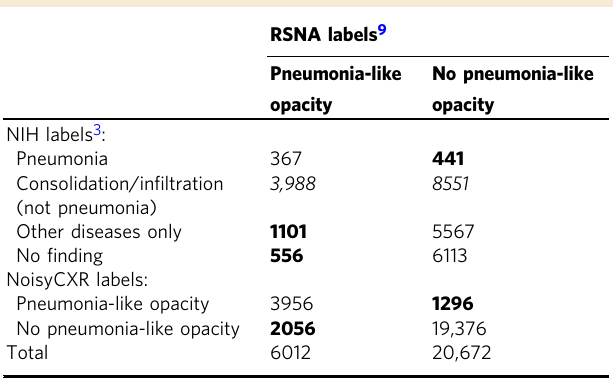
distribution for relabel sampling to P label ð Pneumonia opacity Þ ¼ 0 : 66. If at least one of the boxes had a medium or high con fi dence score, the case is considered easy and we set P label ð Pneumonia opacity Þ ¼ 1. ●